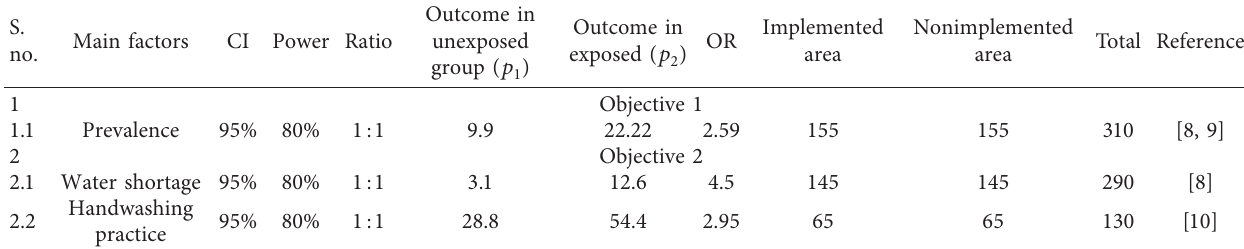
Table 1: Sample size determination of prevalence of diarrhea morbidity in CLTSH implemented and nonimplemented areas in Gamo Gofa Zone, 2018.